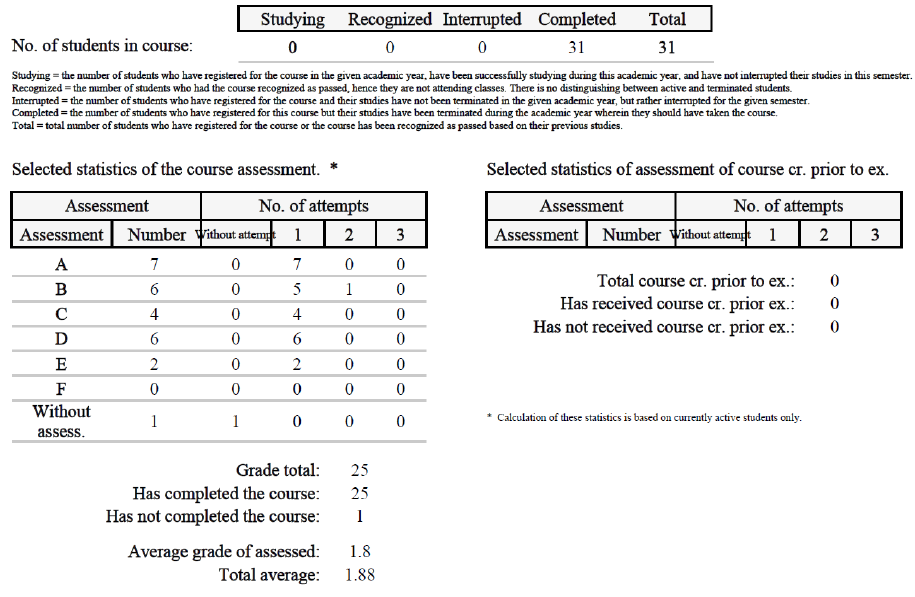
Figure 15. Results of all students during the academic year 2020/2021.